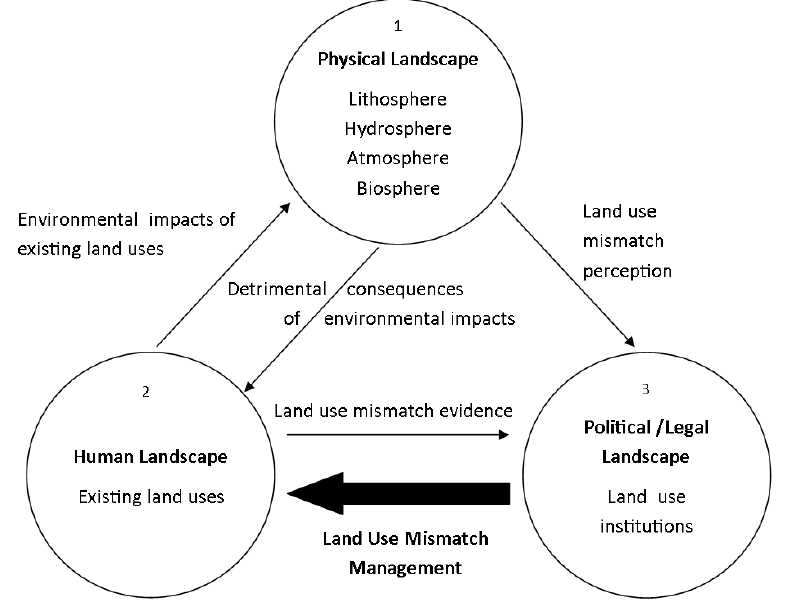
Figure 1. The Land Use and Society (LU&S) model (adapted from